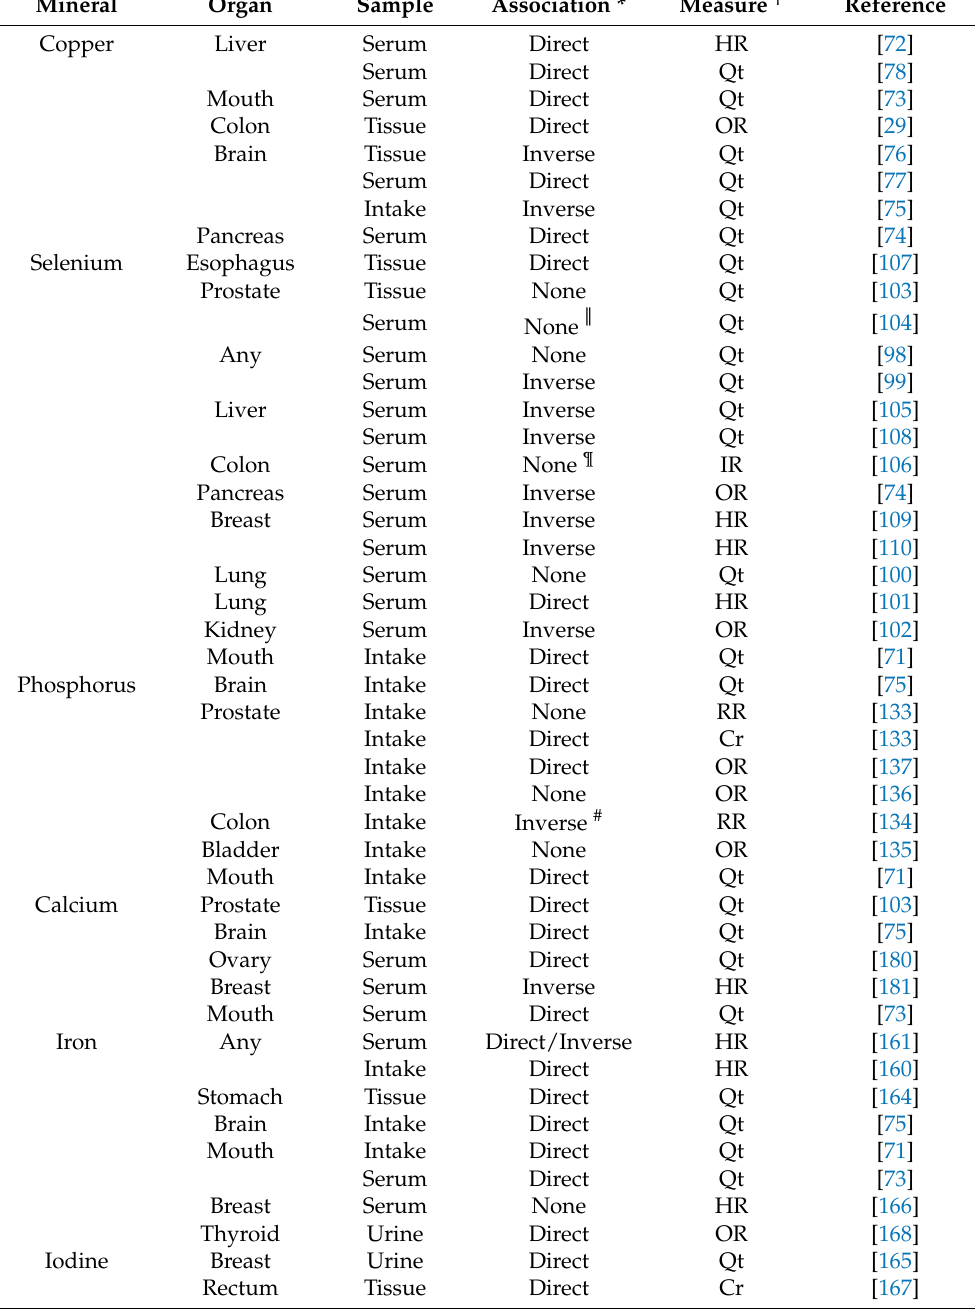
Table 4. Summary of the daily intake of minerals in the studies retrieved for the present work.